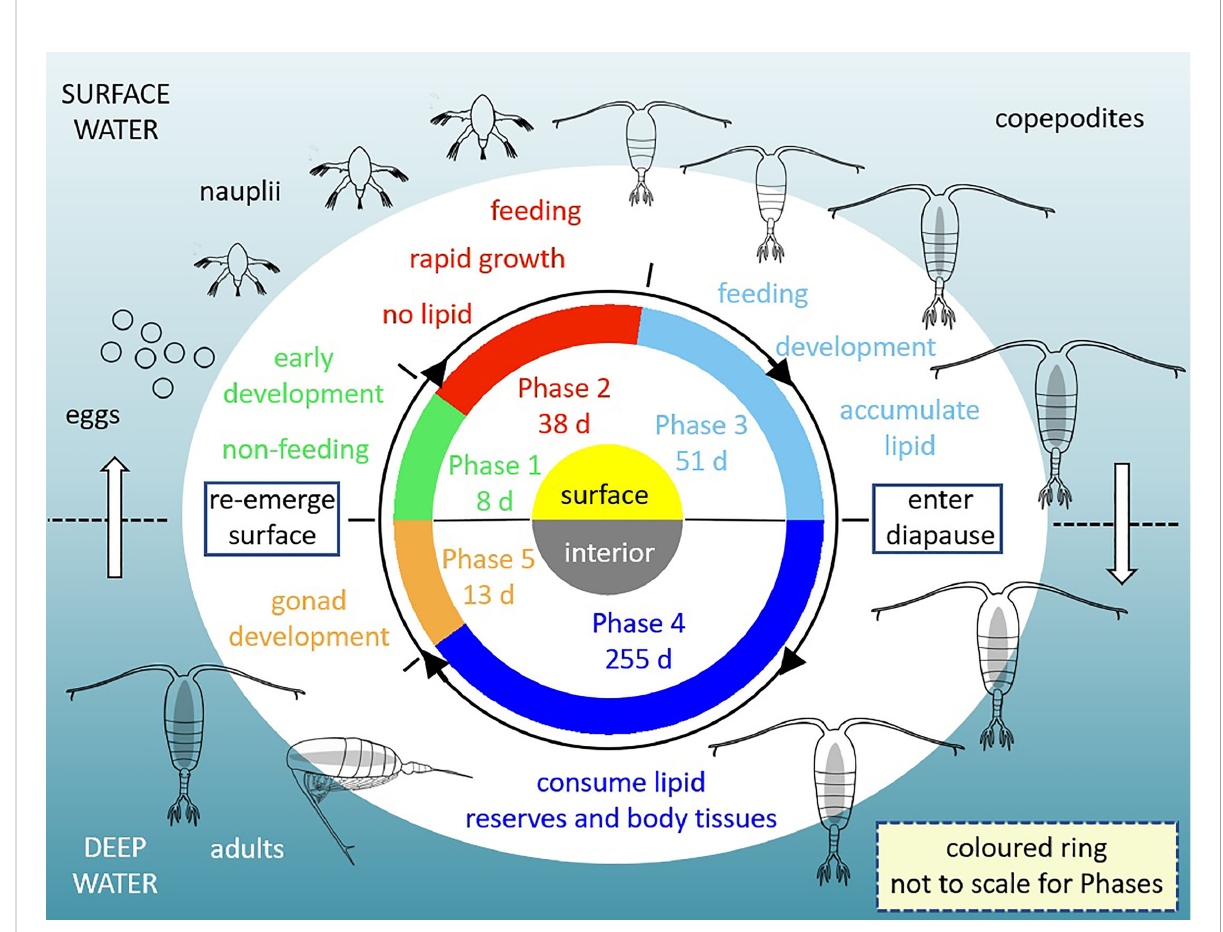
FIGURE 2 Diagram showing model Phases 1-5 representing the fi rst year in the life history of a Calanoid copepod (outer images; redrawn from Mayor et al., 2020; grey interior represents lipid sac). Phase durations shown are for the standard model run with default parameter values. Egg production in spring and summer of the second year (Phase 6) is not